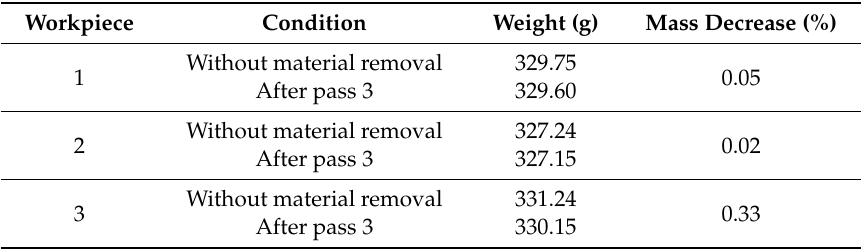
Table 2. Variation of masses and weights of the workpieces.